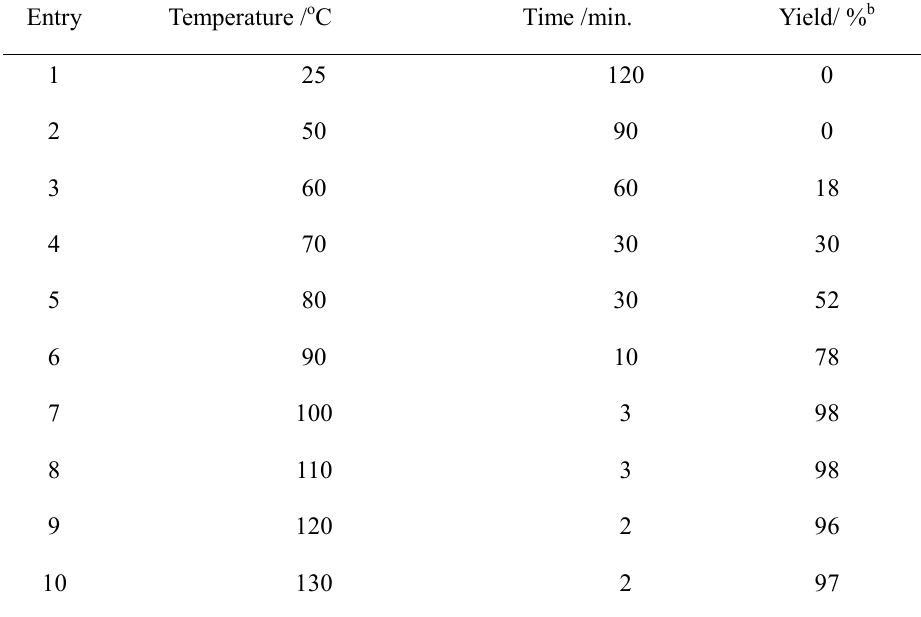
Table 1. Temperature optimization for the synthesis of synthesis of 2-phenylthiazoline a . Entry Temperature / o C Time /min. Yield/ % b 25 120 0 50